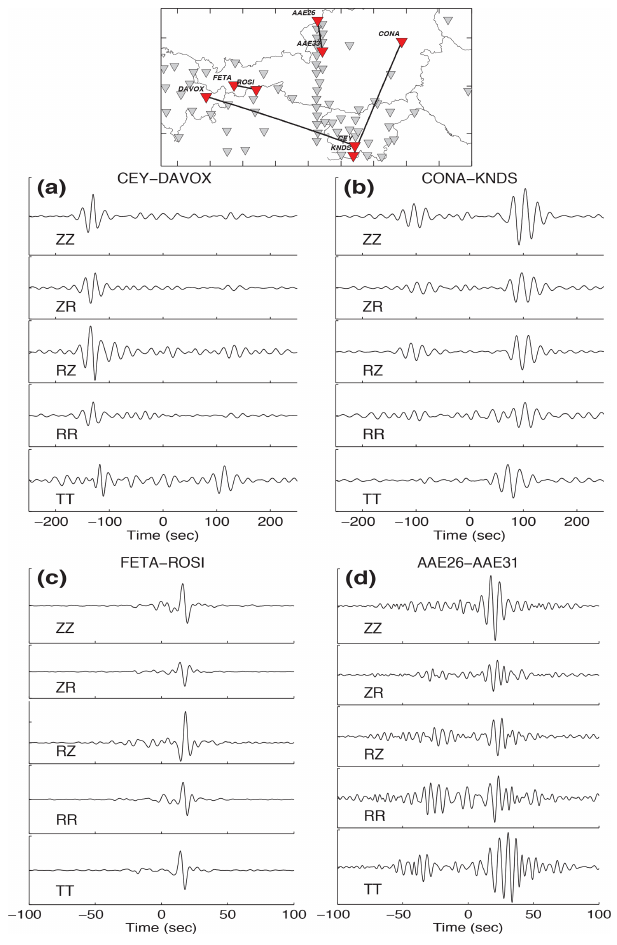
Figure 2. Examples of stacked and rotated cross-correlations from 2 years of data (2014–2015). The top panel shows the inter-station paths and geometry. CEY-DAVOUX and CONA-KNDS represent long inter-station distance, while FETA-ROSI and AAE26-AAE31 are within a short